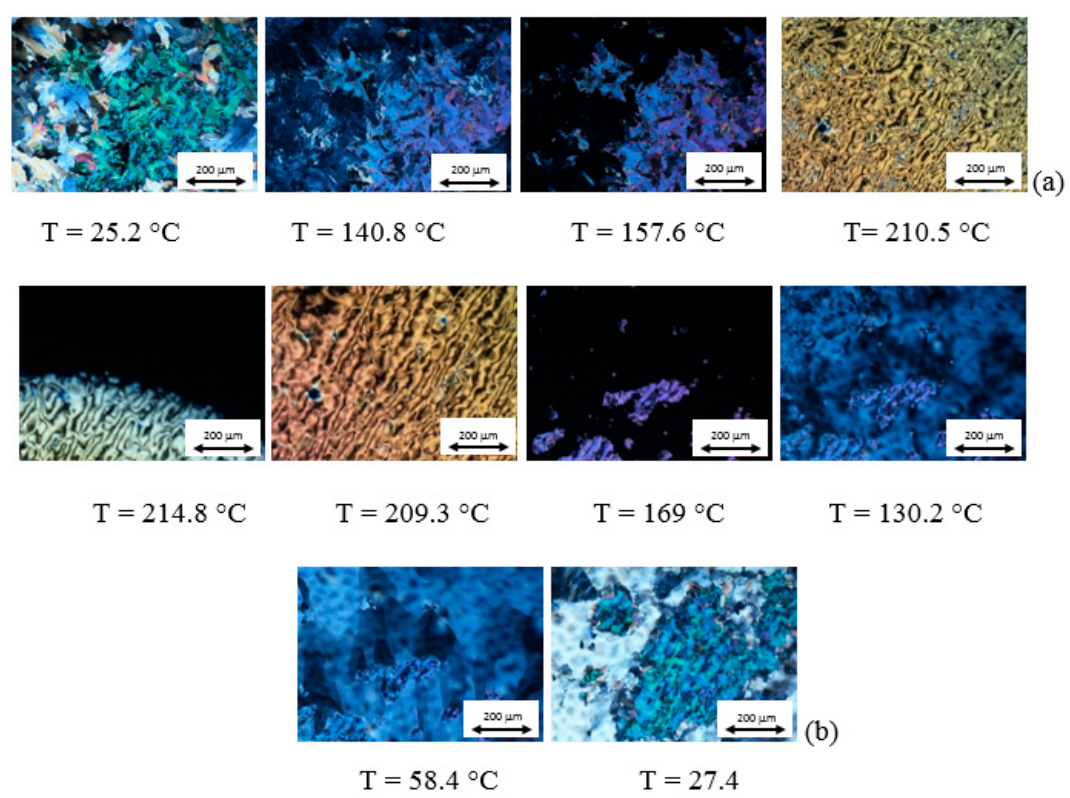
Figure 5. Photomicrographs of the optical textures registered at various temperatures for the AZJ1 during heating ( a ) and cooling ( b ) at a rate of 10 °C/min .